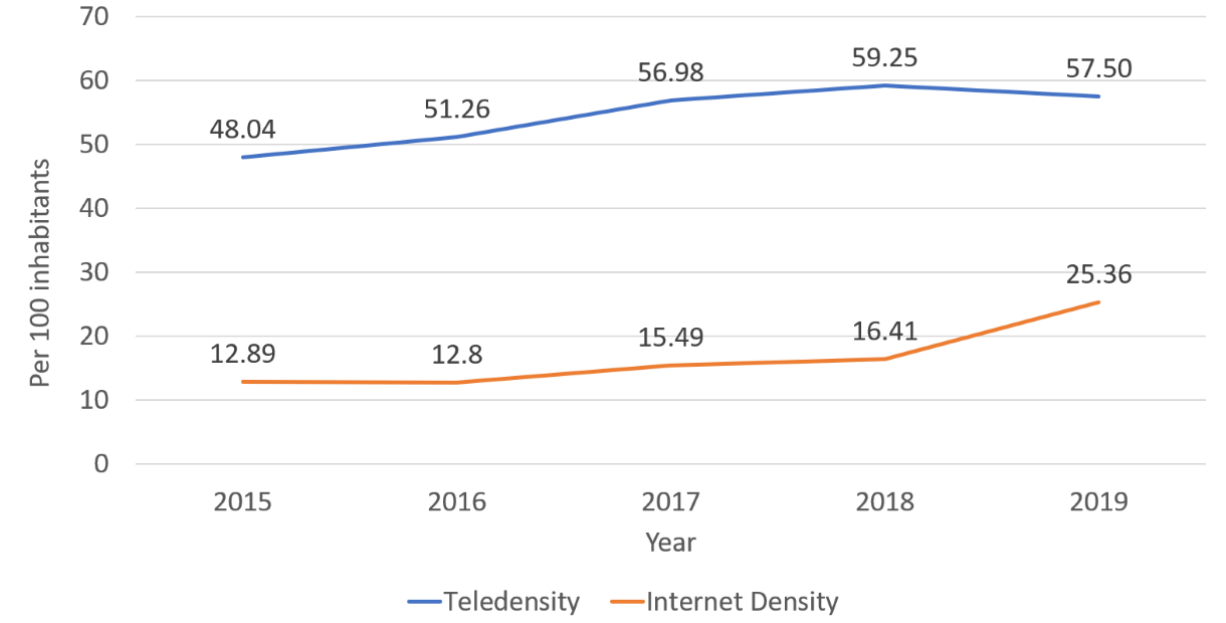
Figure 1. Telephone and internet density in rural